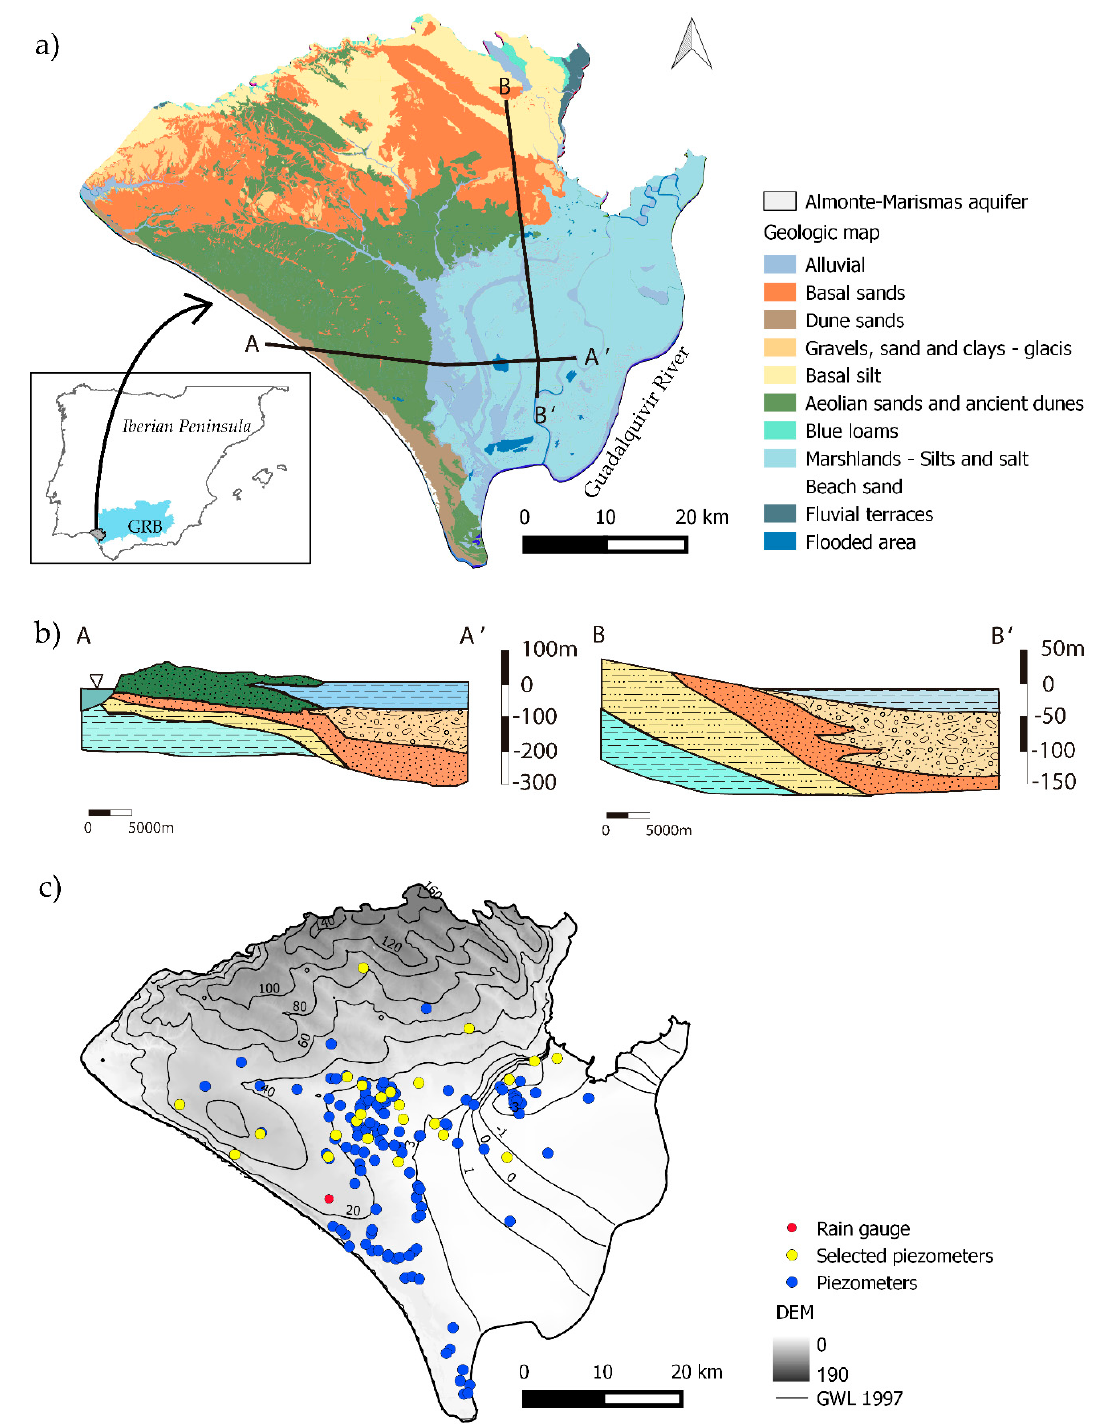
Figure 1. ( a ) Location and geological map; ( b ) Cross sections of Almonte-Marismas aquifer (Guadalquivir River Basin, GRB); and ( c ) Piezometers and Almonte-Acebuche rain gauge locations and piezometric surface at the end of 1997, taken from Guardiola-Albert et al. [25]. DEM: Digital Elevation Model.